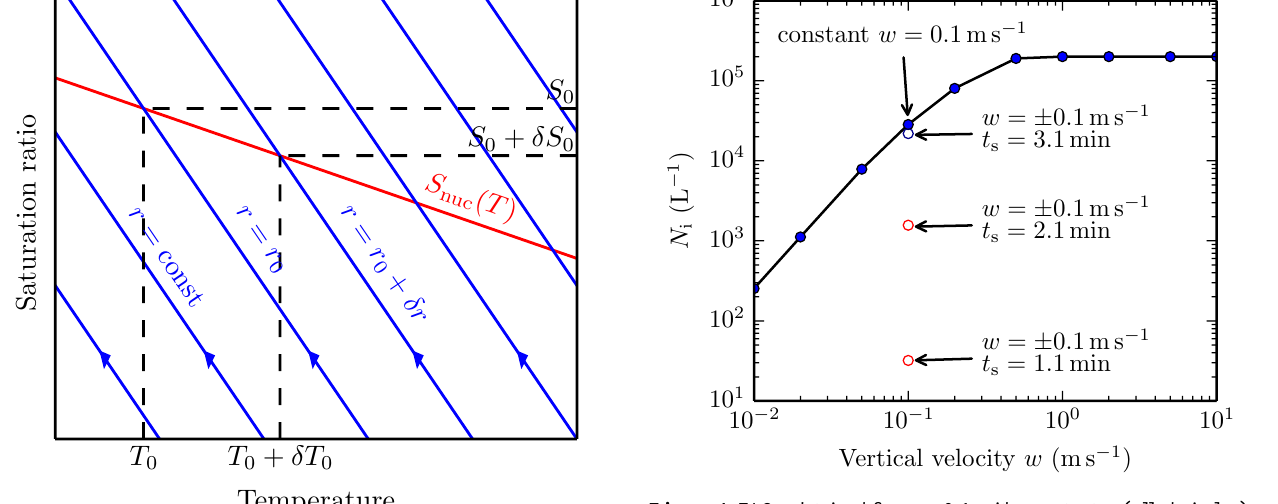
Figure 4. INCs obtained for α = 0 . 1 with constant w (filled circles), and with w = ± 0 . 1ms − 1 (open circles), see Eq. (7). Vapour-limit events are shown in blue and temperature-limit events are shown in